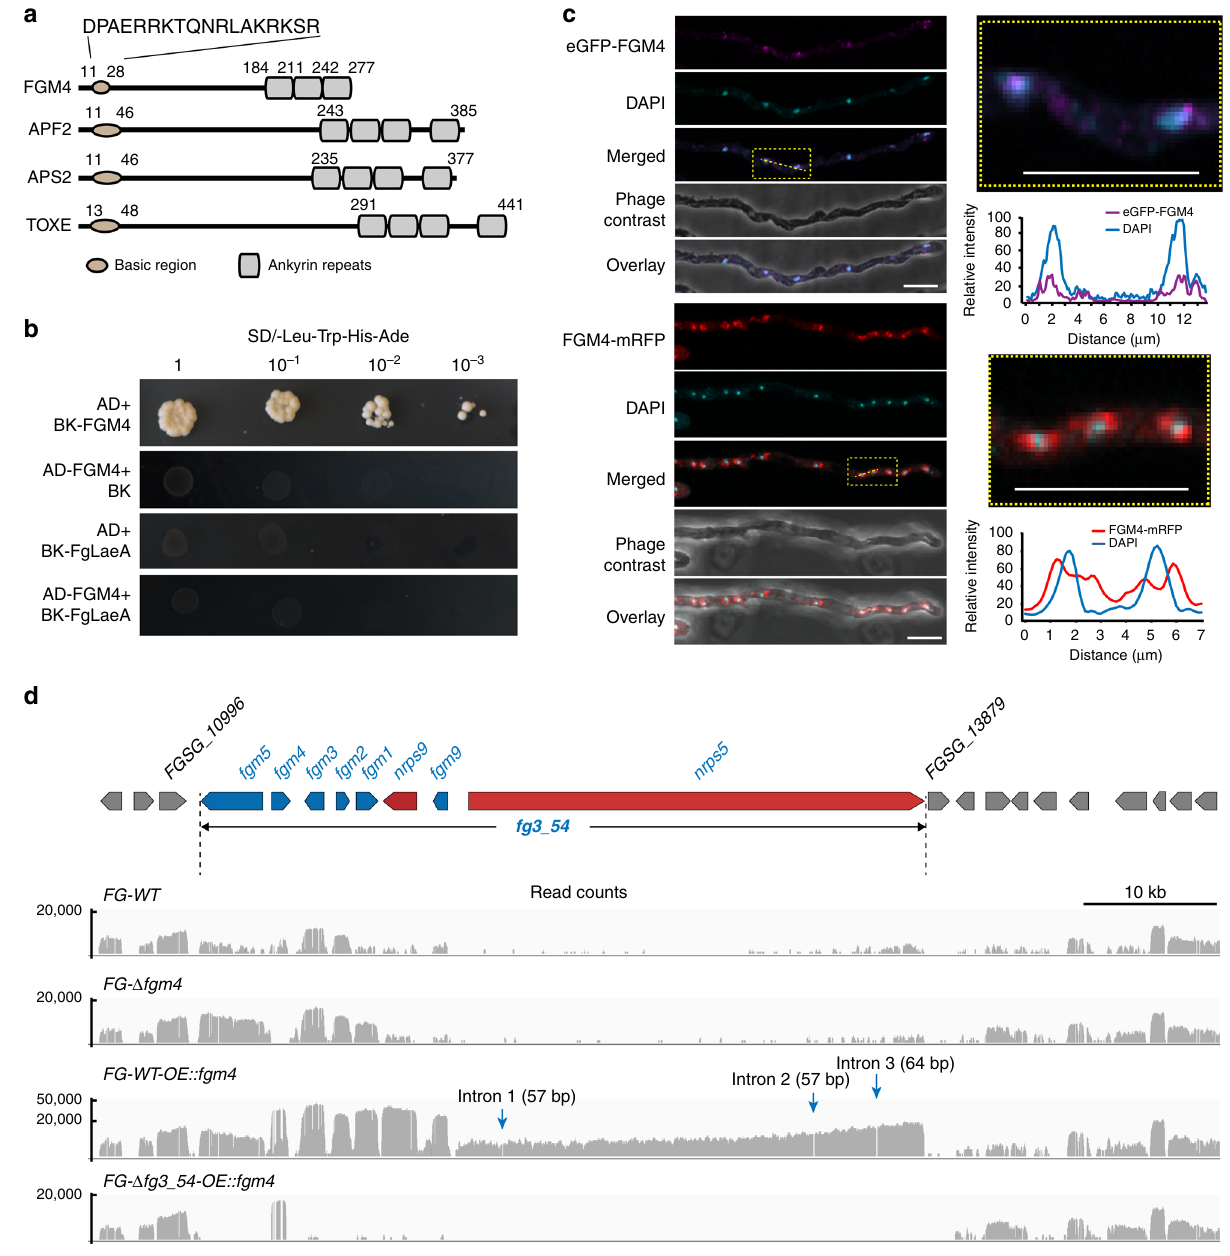
Fig. 3 FGM4 is the key regulator inducing expression of the fg3_54 cluster. a FGM4 has a similar domain structure to several basic-ankyrin repeats transcription factors. Three ankyrin repeat domains are predicted in the C terminal region. Numbers indicate amino acid residue positions. b Growth of yeast cells cotransformed with representative constructs. Transformants were spotted on SD/-Leu-Trp-His-Ade medium. c Subcellular localization of FGM4 as determined by confocal microscopy. eGFP and mRFP were fused to the N terminus and C terminus of FGM4, respectively. Relative signal intensities of the respective emission fl uorescence along the lines drawn across the hyphae are charted on the right. Bars represent 10 μ m. d Coverage plots of RNA-seq reads over the fg3_54 cluster and fl anking